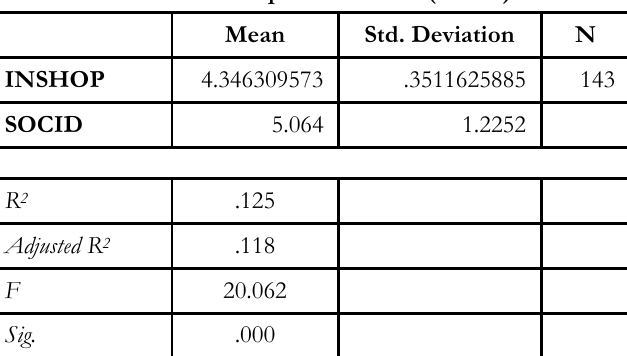
Table 4: Descriptive Statistics (Overall)